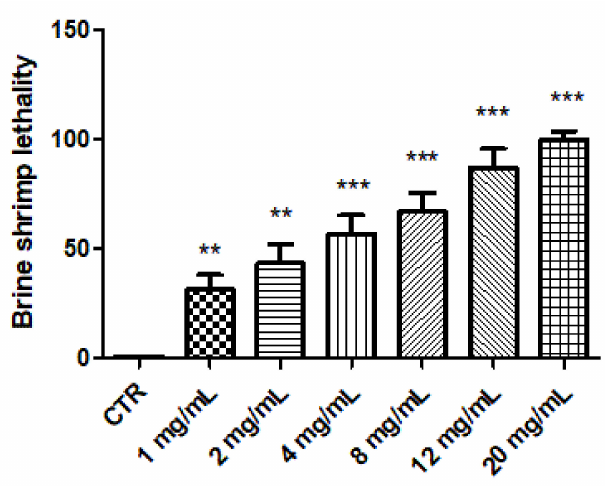
Figure 5. Effects induced by the mixture (mg/mL) on the survival of Artemia salina (brine shrimp lethality assay). ANOVA, p < 0.0001; *** p < 0.001, ** p < 0.01 vs.